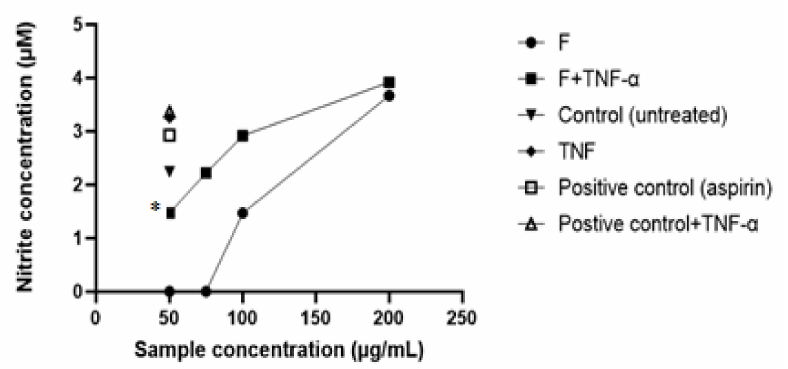
Figure 6. NO inhibitory potential of formula F. Each point indicates the mean ± SD of three measure- ments. * p < 0.05 was considered significantly different compared with the unstimulated group.